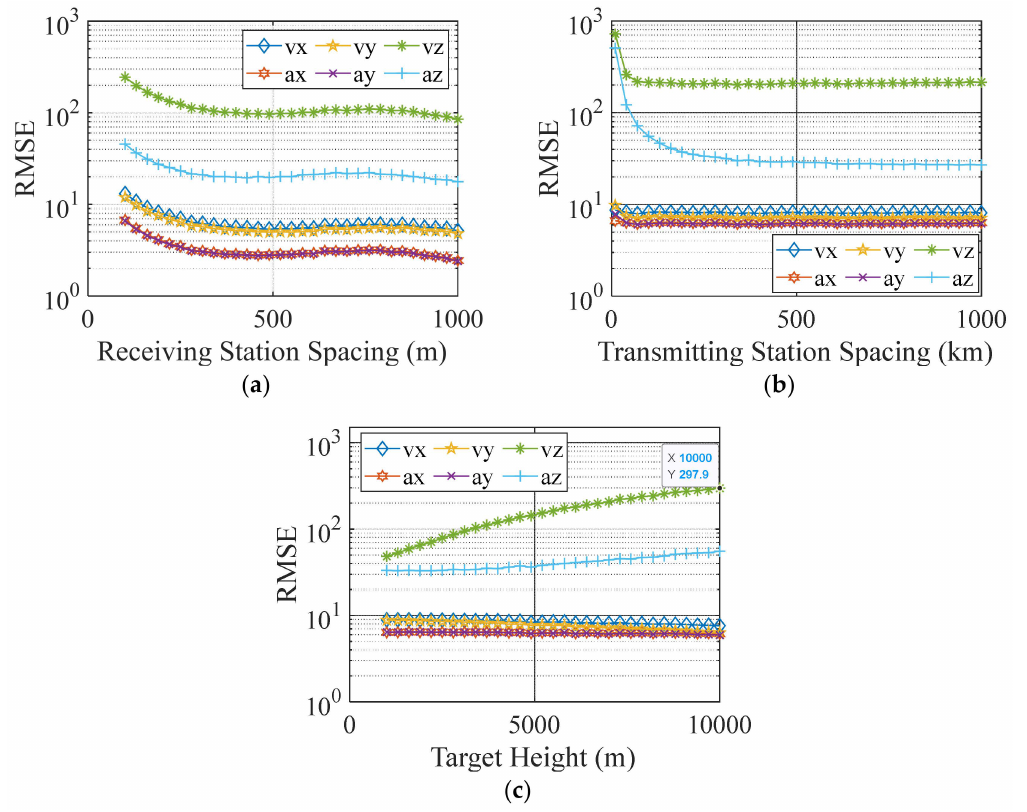
Figure 5. Influence of system structure on parameter estimation accuracy. ( a ) Influence of receiver spacing. ( b ) Influence of transmitter spacing. ( c ) Influence of target